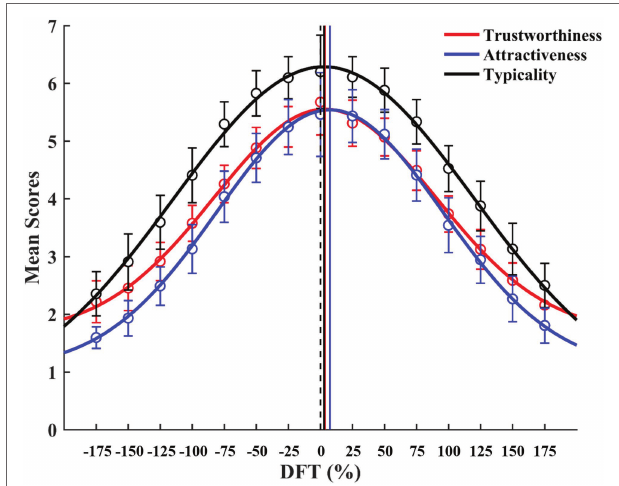
FIGURE 3 | Mean trait judgments as a function of DFT based on all 20 tested face continua. Black vertical dotted line represents the location of the average face (DFT = 0%). Solid vertical lines represent locations of the predicted DFT for peaks of mean trustworthiness (red), attractiveness (blue), and typicality (black) judgments. Error bars represent 95% confidence